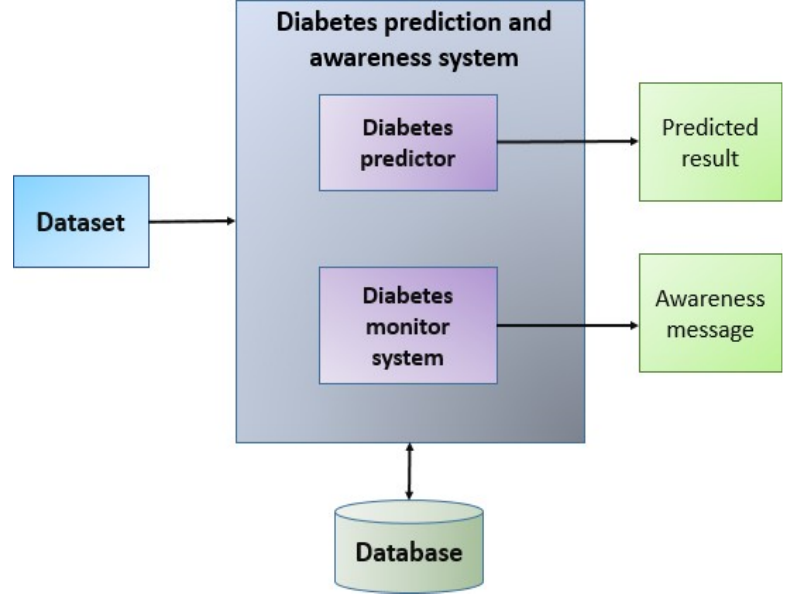
Figure 3. Proposed data architecture.